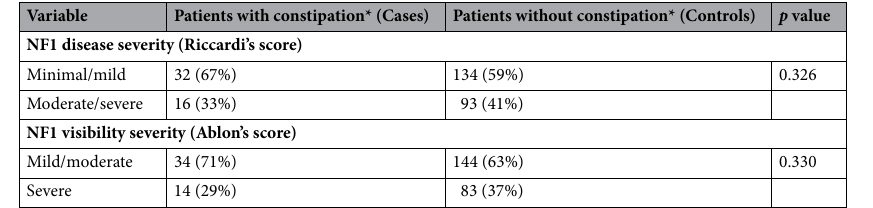
Table 1. Disease severity and visibility severity in 275 patients scored by a physician. *Data missing in one patient in each group.